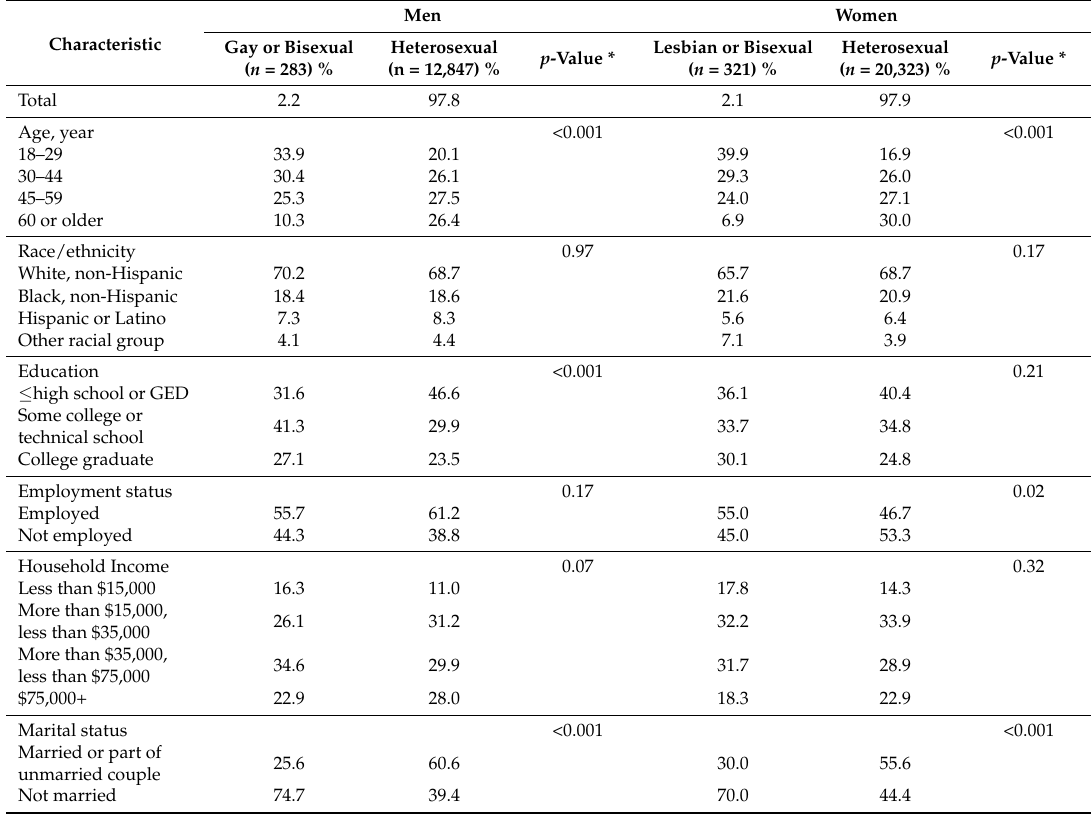
Table 1. Demographic characteristics by gender and sexual orientation identity, North Carolina Behavioral Risk Factor Surveillance System,